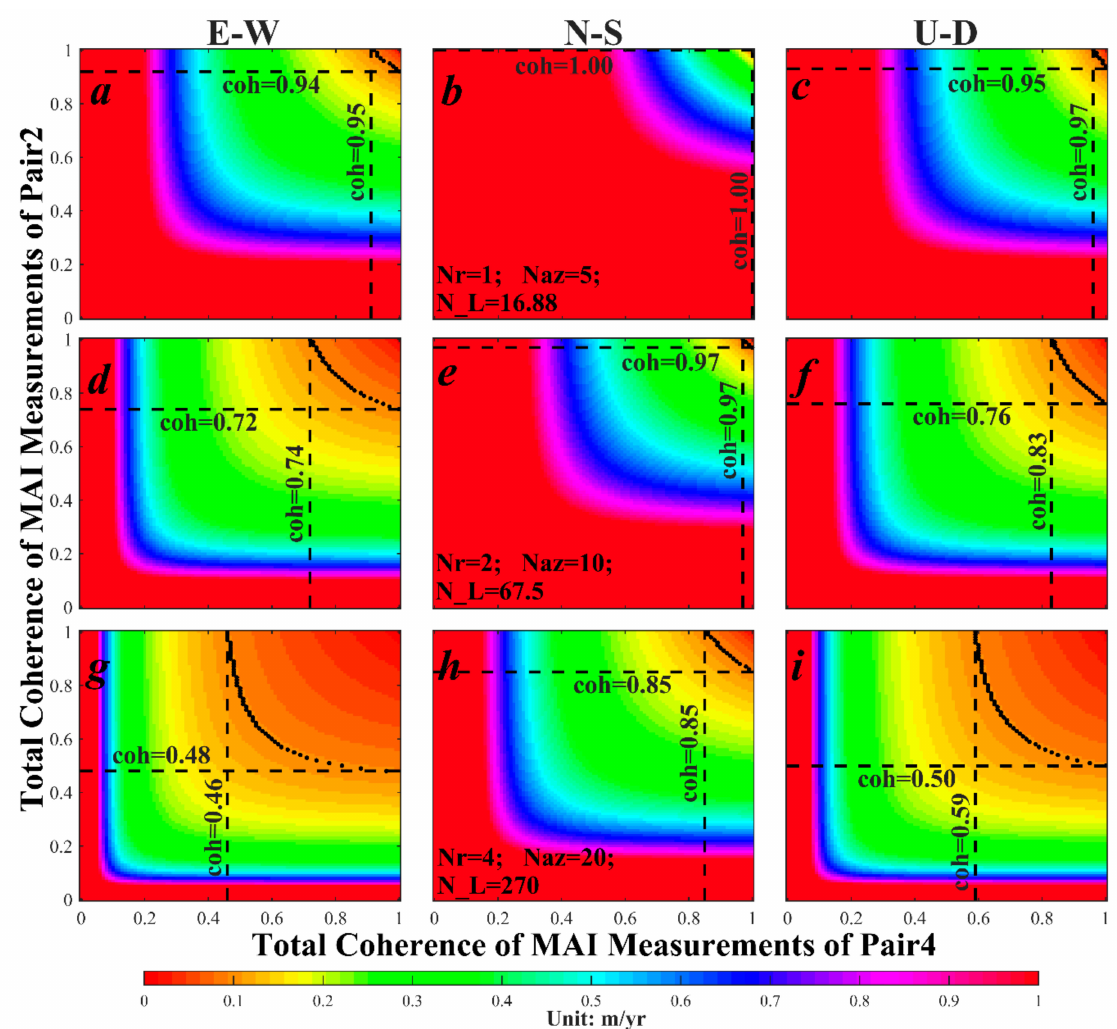
Figure 3. Root mean squared errors (RMSEs) of 3D deformation along the east ( a , d , g ), north ( b , e , h ), and vertical ( c , f , i ) directions with a different total coherence of MAI observations in Pair 2 and Pair 4 under the look numbers of 1 × 5 (range × azimuth, ( a – c )), 2 × 10 ( d – f ) and 4 × 20 ( g – i ), respectively. N_L denotes the effective look